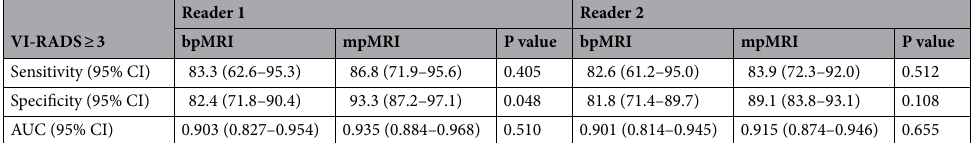
Table 2. Diagnostic performance between both readers in predicting muscle invasion by bladder cancer. AUC area under the curve, bpMRI biparametric magnetic resonance imaging, mpMRI multiparametric magnetic resonance imaging, VI-RADS Vesical Imaging Reporting and Data System, CI confidence